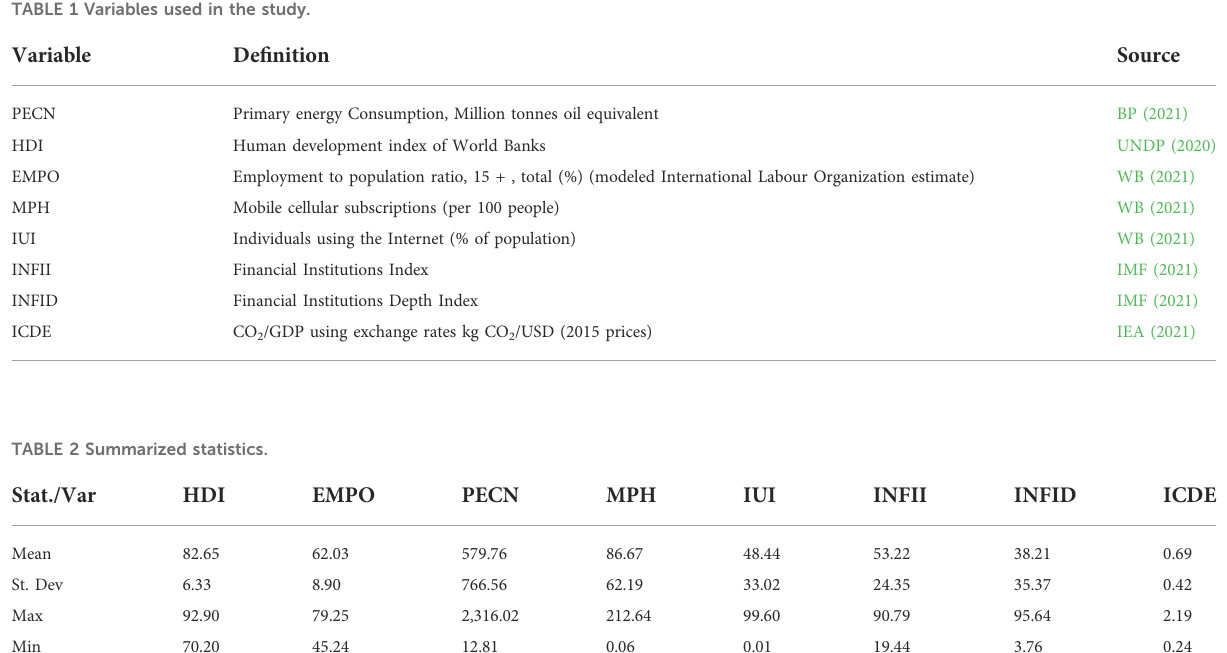
TABLE 1 Variables used in the study.